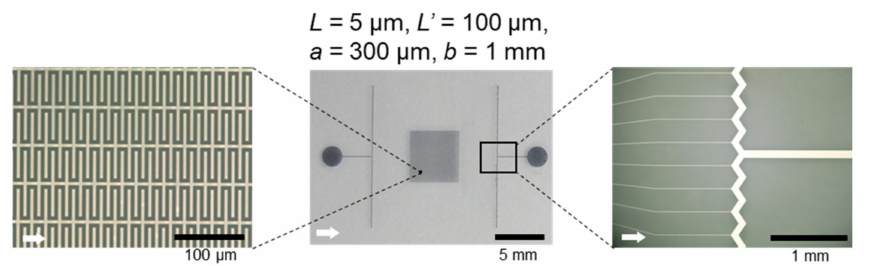
Figure 4. Optical micrographs for extended-edge interdigitated array electrodes fabricated by nanoparticle chemisorption printing. The white arrows indicate the blade-sweep direction during the nanoparticle chemisorption